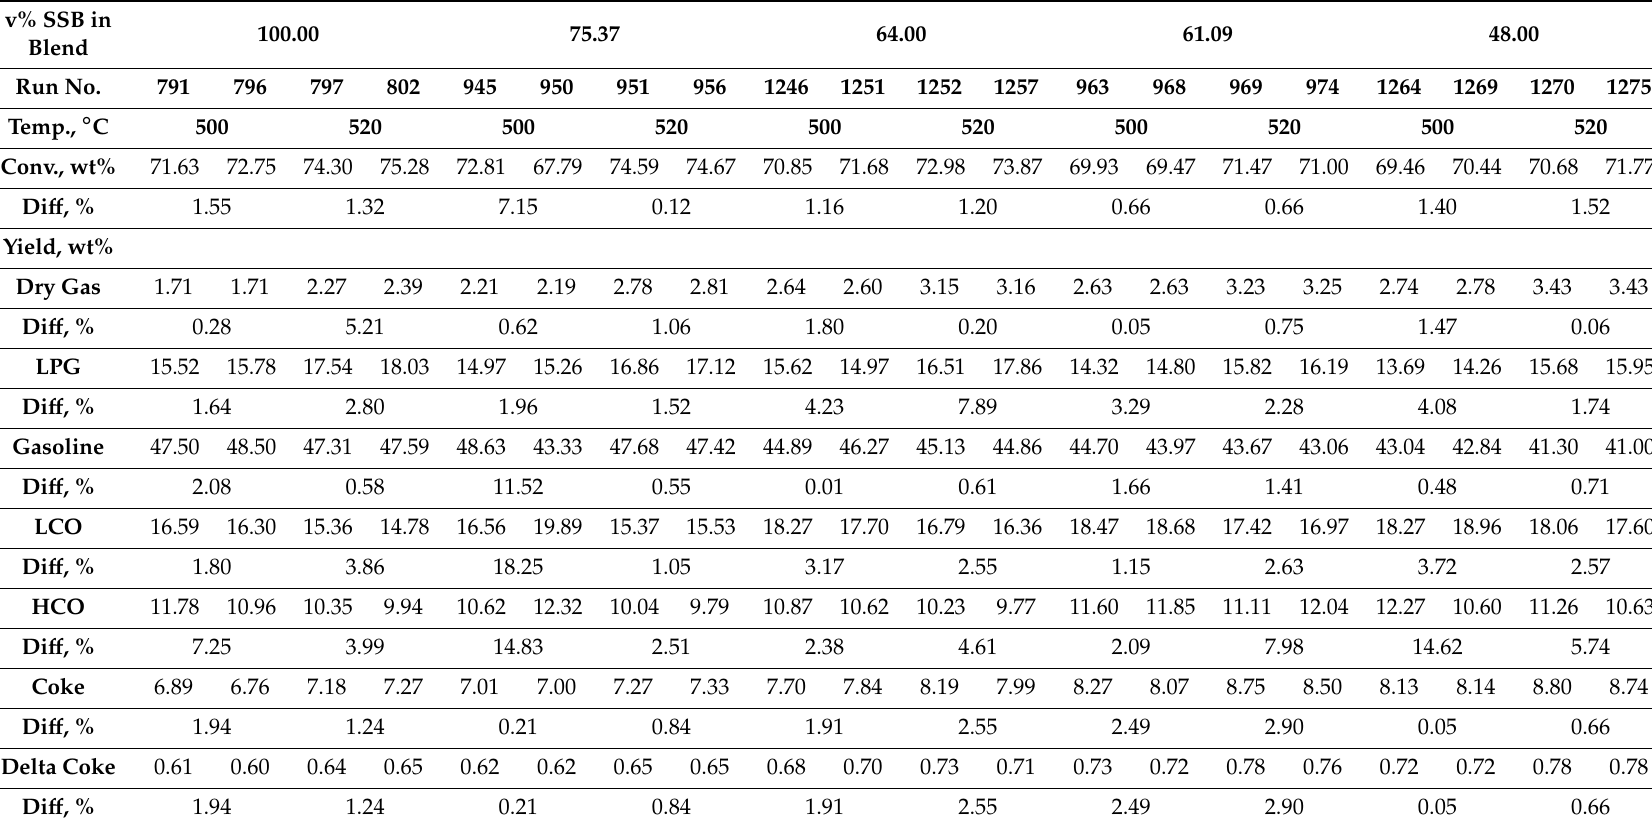
Table 3. Repeatability data of conversions and yields at 11.0 C / O ratio and two temperatures for five